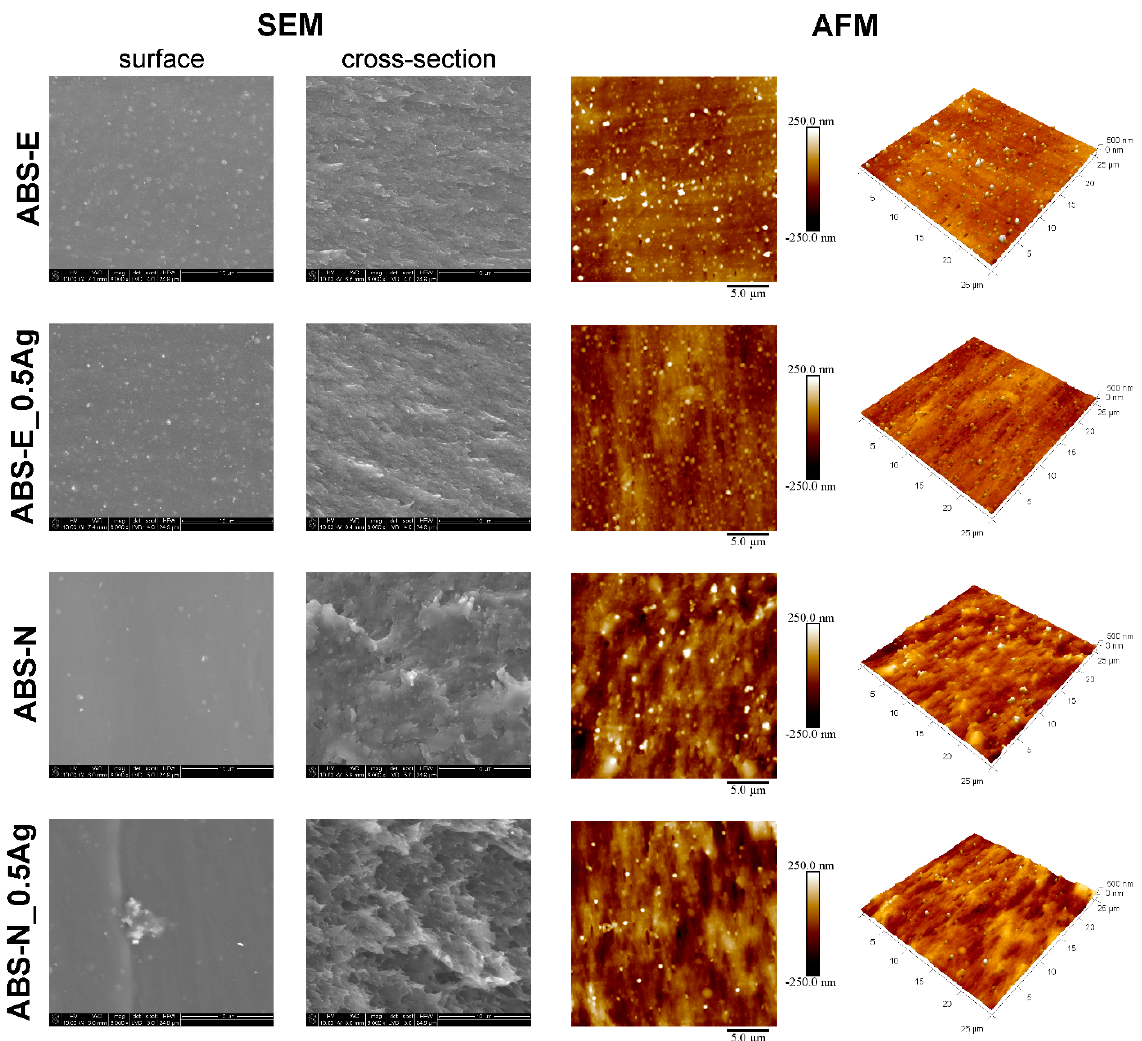
Figure 1. SEM and AFM tapping mode images of pure polymers and polymers containing silver nanoparticles.